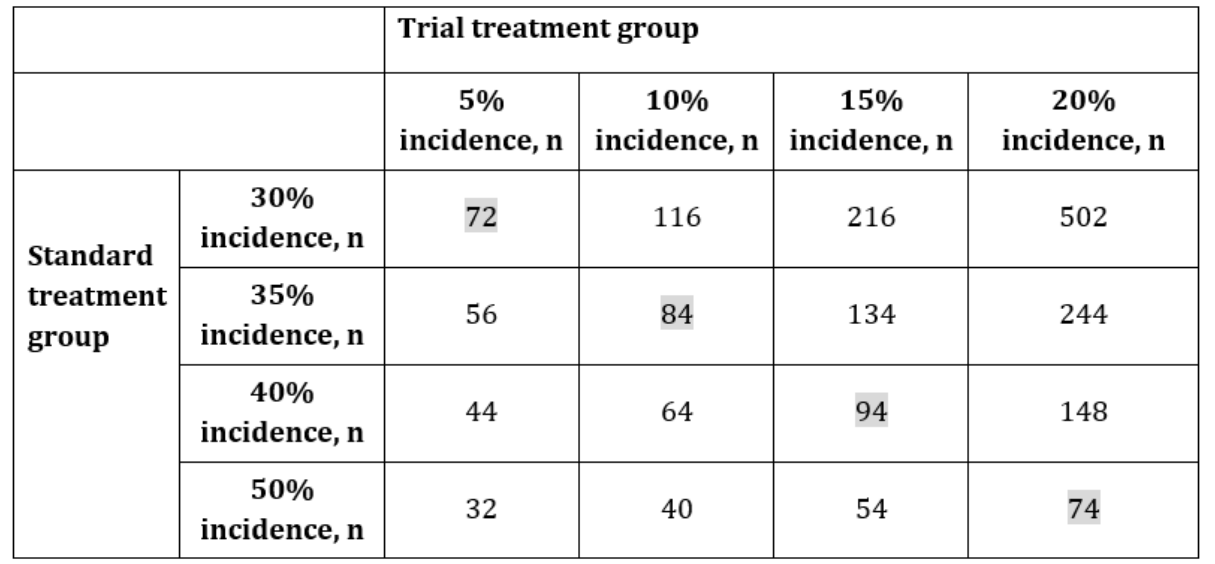
Figure 3. Sample size calculation. Numbers highlighted in grey represent the sample sizes necessary for detecting effects with a power of 80% in cases where a 25% pneumonia onset control is